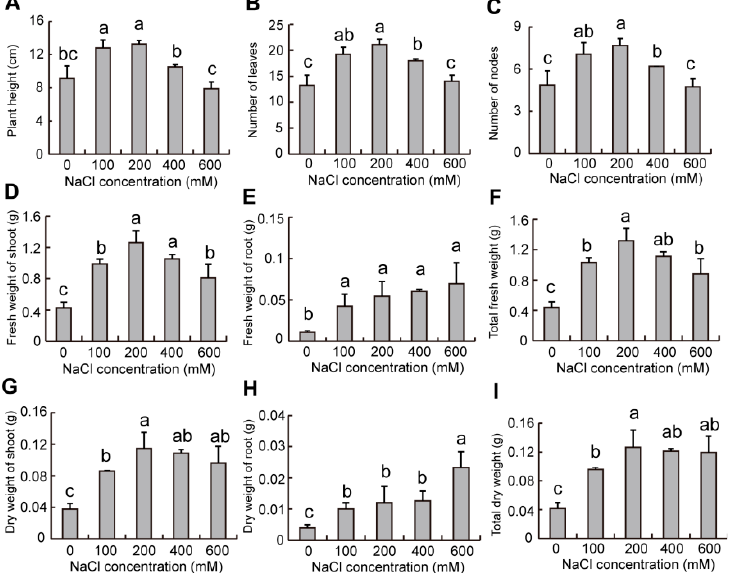
Figure 9. Effects of NaCl on the morphological indicators of plants from black seeds of S. liaotungensis . The determination of plant height ( A ), numbers of leaves ( B ) and nodes ( C ), fresh weight of shoot ( D ), root ( E ), and total ( F ), and dry weight of shoot ( G ), root ( H ), and total ( I ) of plant from black seeds. There were 5 plants counted for each replicate. Different letters show significant differences (LSD test, p < 0.05).